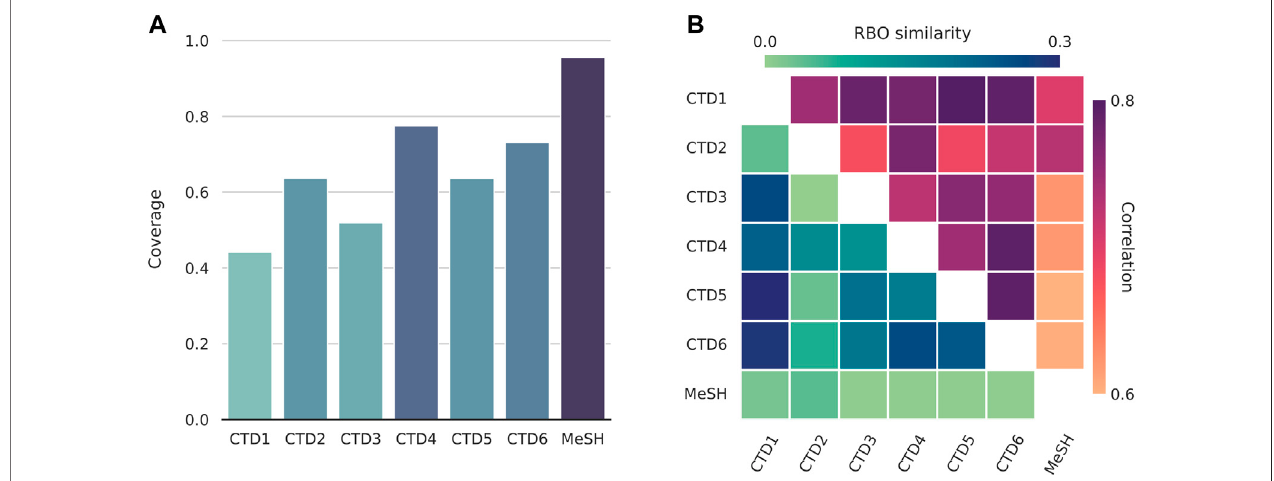
FIGURE 2 | Comparisons between the different disease spaces. CTD1-6: Genes, Chemicals, Pathways, GO-BP (Biological Process), GO-CC (Cellular Component), and GO-MF (Molecular Function). (A) Disease term coverage for the 6 CTD (Comparative Toxicogenomics Database) spaces and MeSH (Medical Subject Headings).Thelatter,togetherwithGO-BPandGO-MF,arethemostenrichedspaces,encodingabout96%,78%,and73%,respectively,ofallthediseasetermsfound in text. (B) RBO (Rank-Biased Overlap) similarities and Pearson correlations between disease spaces. Although the two are not directly comparable, they seem to be in good agreement with each other, with MeSH being the least and CTD1 (Genes) the highest correlated space, in general.